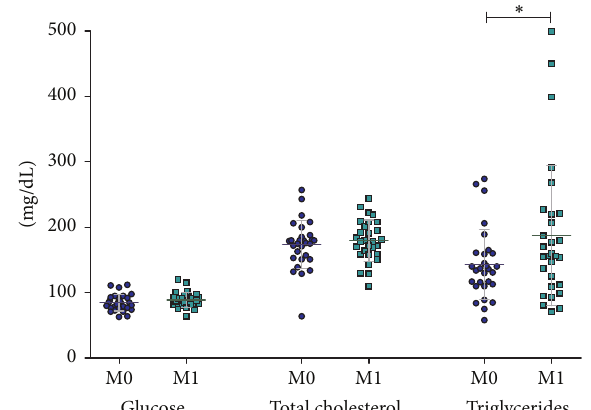
Figure 1: Mean of blood glucose measurements, total cholesterol, and triglycerides of 30 PLWHA, before and after cART initiation. PLWHA: people living with HIV/AIDS; cART: combined antiretroviral therapy; M0: before cART initiation; M1: after cART initiation. Statistical tests: gamma distribution for triglycerides and ANOVA with post hoc Tukey’s tests for the other variables. ∗ 𝑝 < 0.001 .